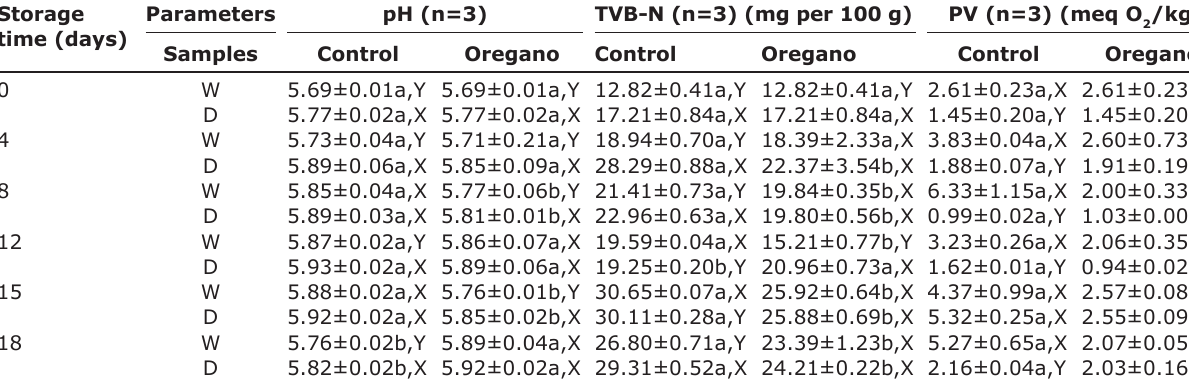
Table-1: Effect of oregano extract with vacuum-packaging on pH, TVB-N, and PV in white (W) and dark (D) muscles of frigate tuna fillets stored at refrigerated (3±1°C) conditions. Storage time (days)